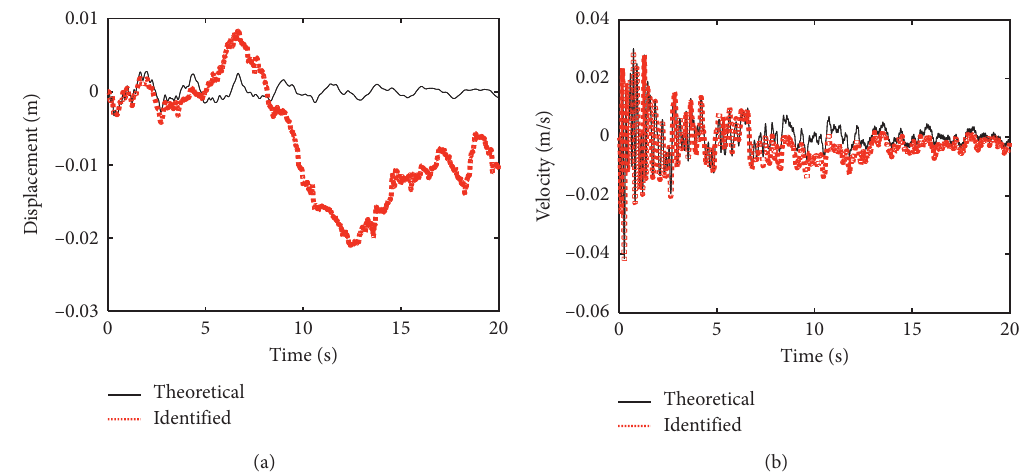
Figure 4: (a) Theoretic and determined vertical shift at node 7. (b) Theoretic and determined vertical speed at node 7.